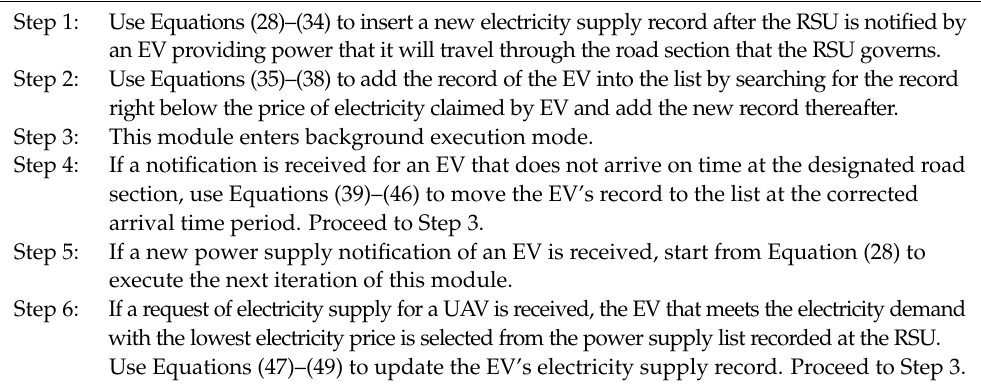
Algorithm 3 Charging and Discharging Management at The Roadside